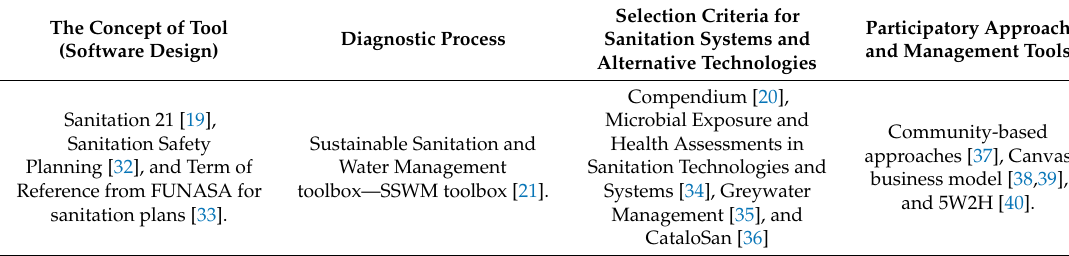
Table 1. Sustainable sanitation management